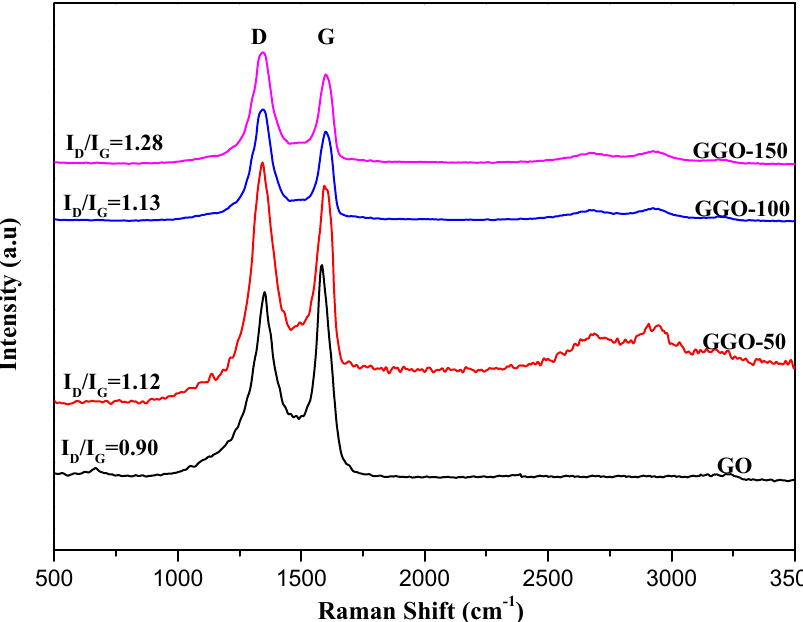
Figure 8. Raman spectra of GO and 3-glycidyloxypropyltrimethoxysilane functionalized-GO (GGO-50, GGO-100, and